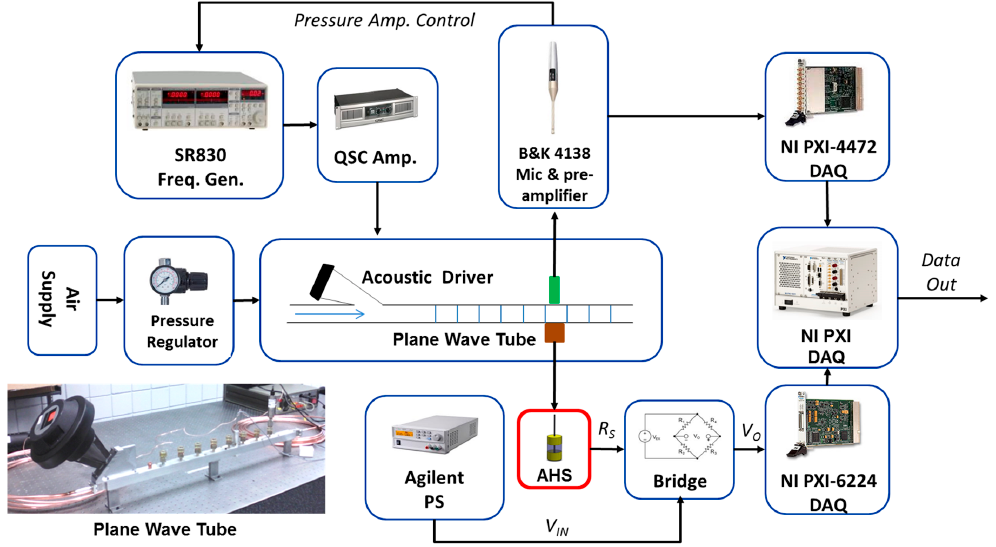
Figure 6. Hybrid plane wave tube for steady and dynamic air flow tests.